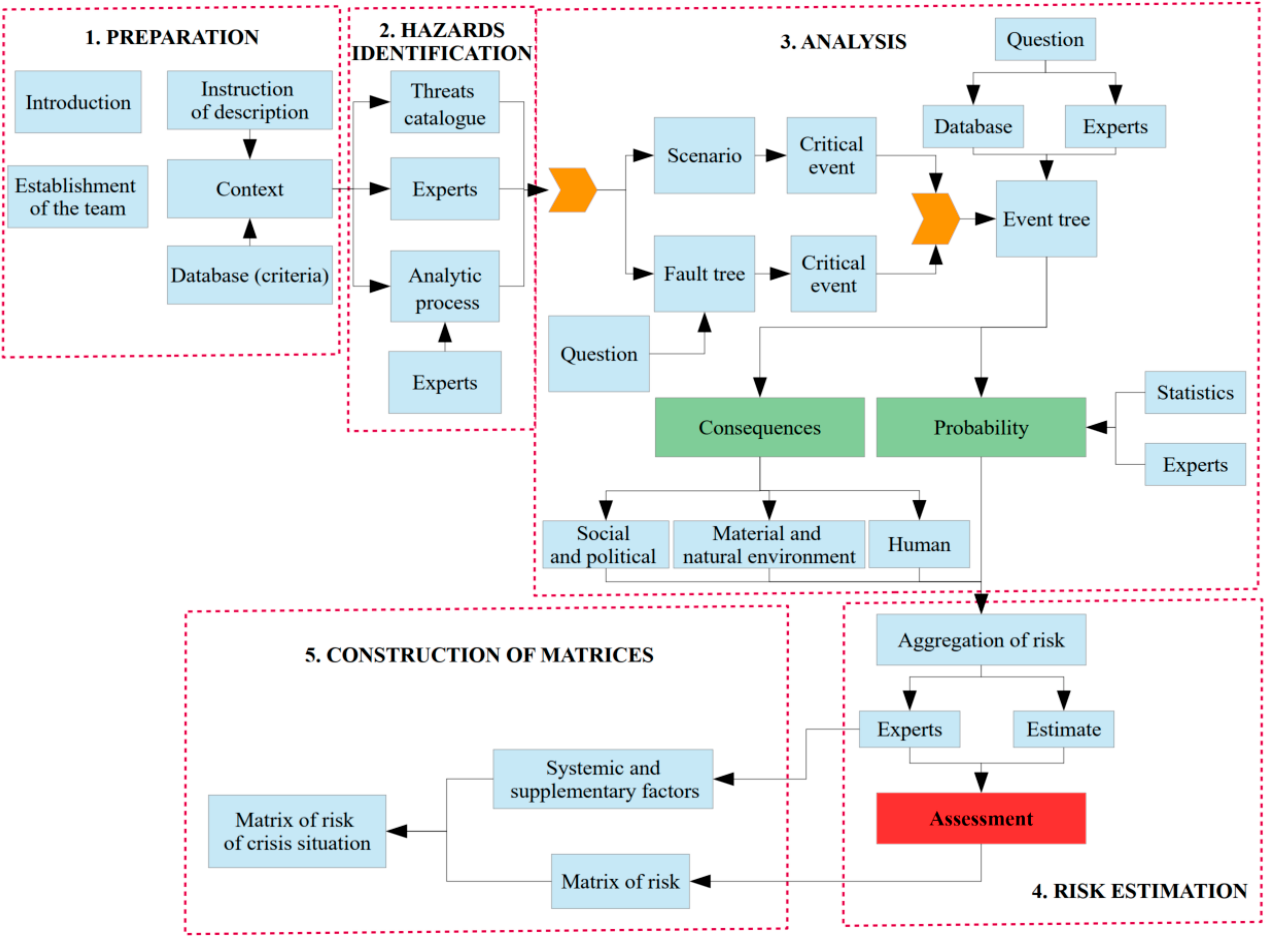
Figure 1. Diagram of risk assessment methodology for crisis management [24].